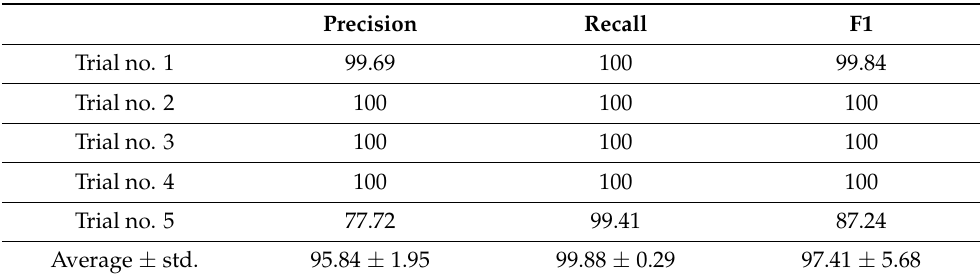
Table 4. Performance metrics (%) of the five trials of the EfficientNet-B2 model with a transfer learning approach; we report the results of COVID-19